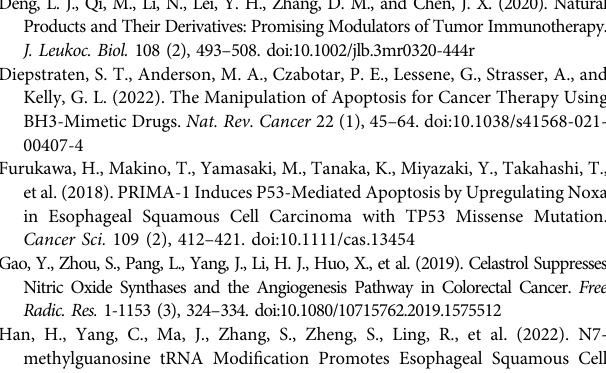
FIGURE 6 | the tumor growth of ESCC. Celastrol coordinatively triggered DR5-dependent extrinsic apoptosis and Noxa-dependent intrinsic apoptosis through transcriptional activation of ATF4. FoxO3a-Bim pathway contributed to celastrol-induced intrinsic apoptosis in ESCC cells. pp denotes p < 0.01, ppp denotes p < 0.001, n.s. denotes not signi fi